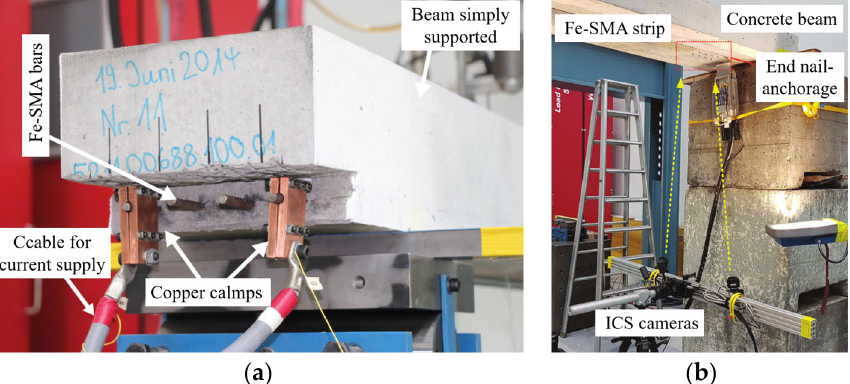
Figure 22. Flexural reinforcement of concrete beams with Fe-SMA [71,99]: ( a ) embedding in shotcrete layer, ( b ) nail–anchor connections.